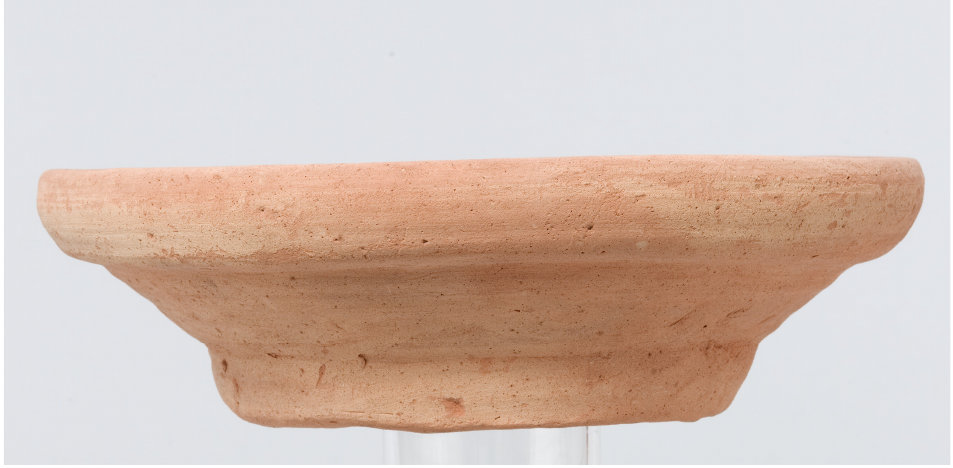
Figure 20. Mortarium, A.I. 2747, D. 28 cm,